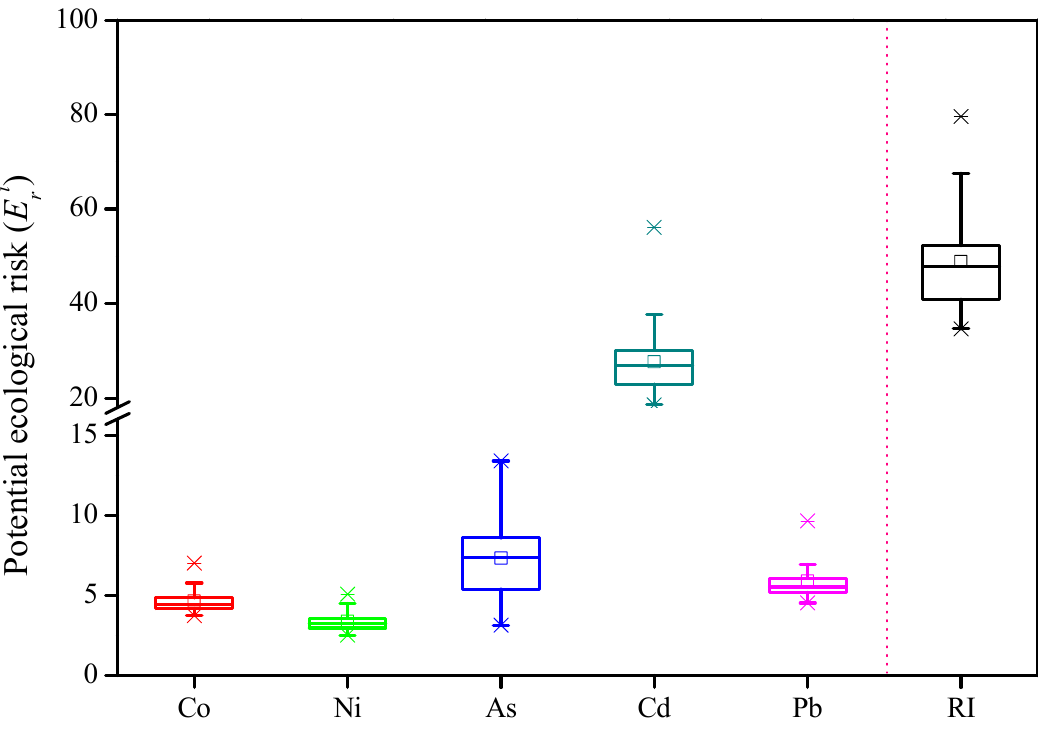
Figure 4. Box plot of potential ecological risk indexes for heavy metals in the S. alterniflora wetland in the Yellow River Delta.